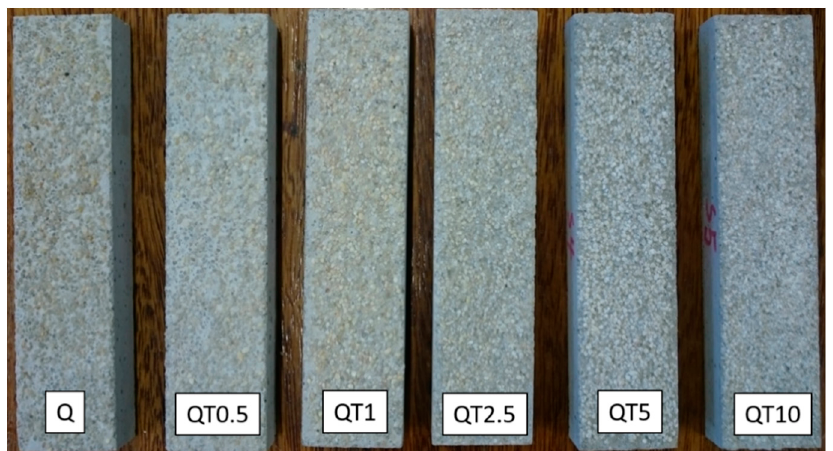
Figure 6. Images of the prepared aggregate exposed mortars. On the top of each sample, 10 g of bare (Q) or TiO 2 -modified quartz sand (QTx) were supported.